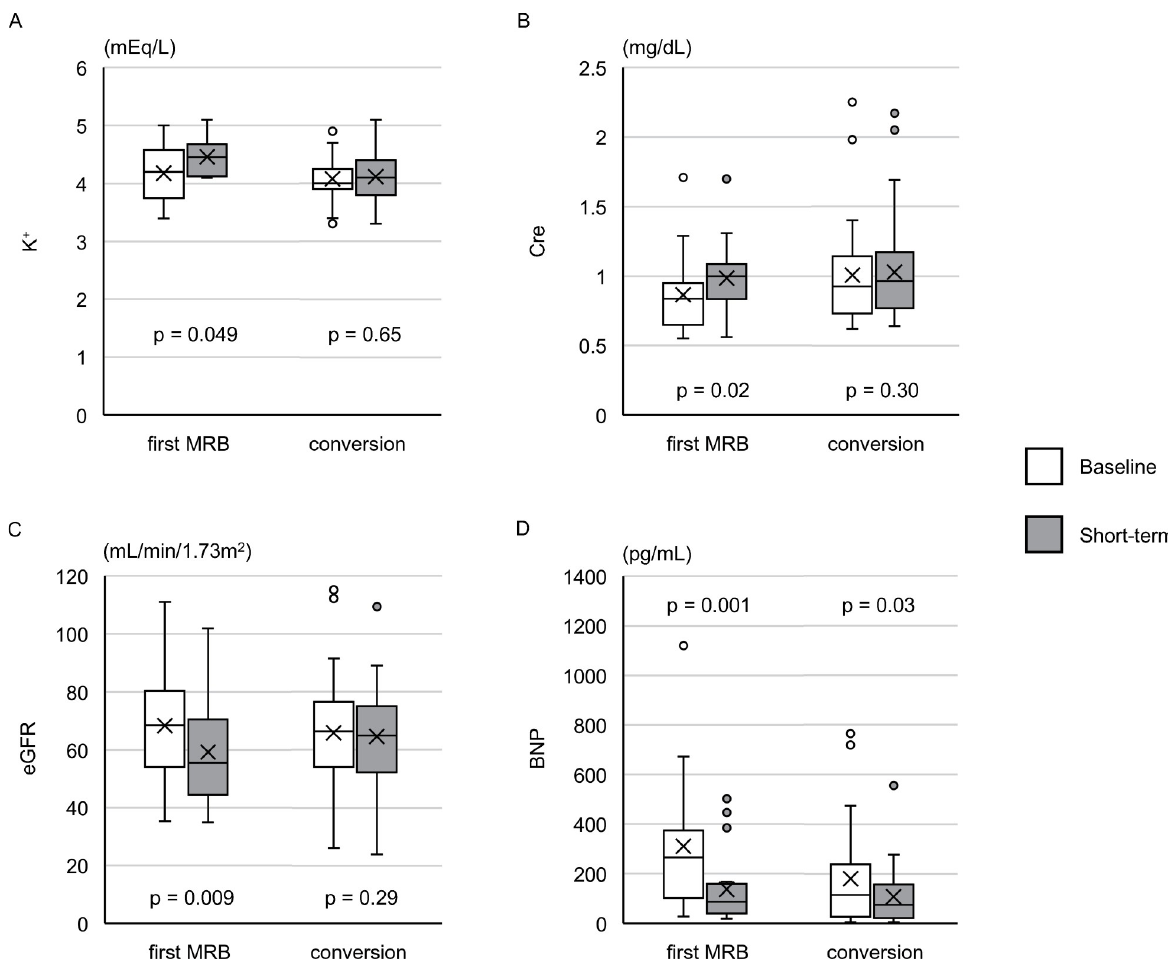
Fig 3. The short-term assessment for the first-MRB and conversion cohorts. Changes in K + (A), Cre (B), eGFR (C), and BNP (D) between baseline and short-term assessments in the first-MRB (n = 20) and conversion (n = 30) cohorts. In each cohort, left bar indicates the baseline, and the right bar indicates the short-term assessment. K + , Cre, eGFR were compared using the paired t-test, and BNP level was compared using the Wilcoxon signed-rank test. K + , serum potassium; Cre, serum creatinine; eGFR, estimated glomerular filtration rate; BNP, brain natriuretic